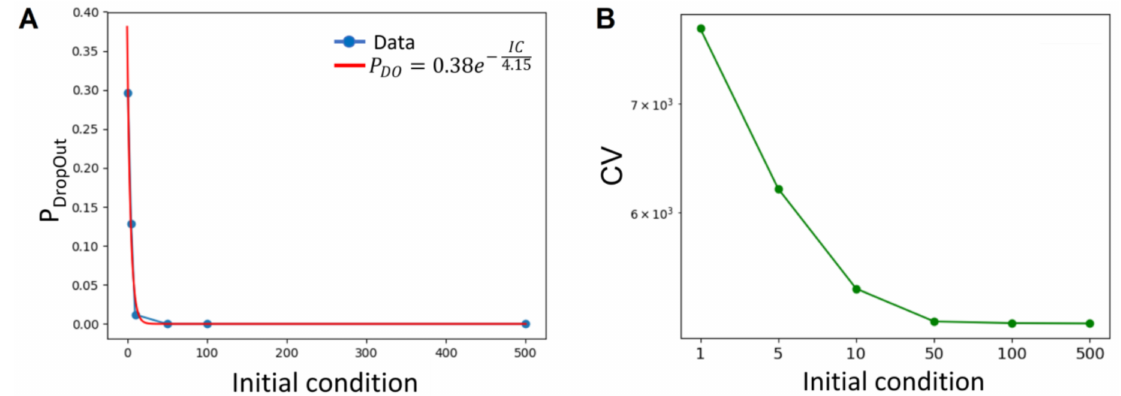
Figure 5. Errors and noise analysis. ( A ) DropOut probability (P DO ) dependency on the RNA initial condition. The computed P DO values (blue dots) for the different initial conditions; the continuous red line is the exponential fitted equation describing the observed points. IC stands for the initial RNA value. The legend shows the value of the parameter with an R 2 = 0.99, we used the nonlinear least squares method using an exponential fitting model. ( B ) Coefficient of variation (CV) for the different initial